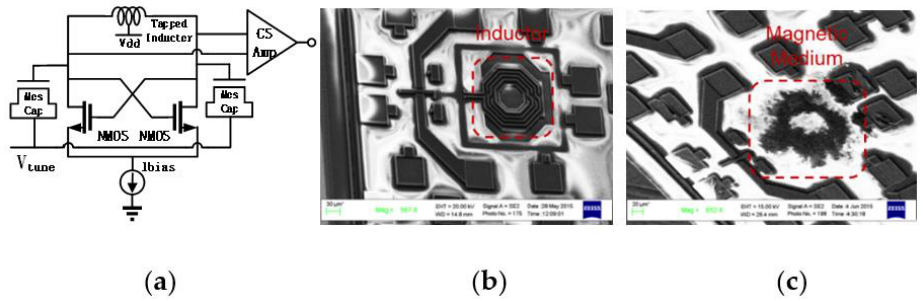
Figure 8. An LC-VCO in 180 nm SOI CMOS using magnetic-cored inductor: ( a ) schematic, ( b ) without magnetic core, and ( c ) with magnetic core for the inductor [24].